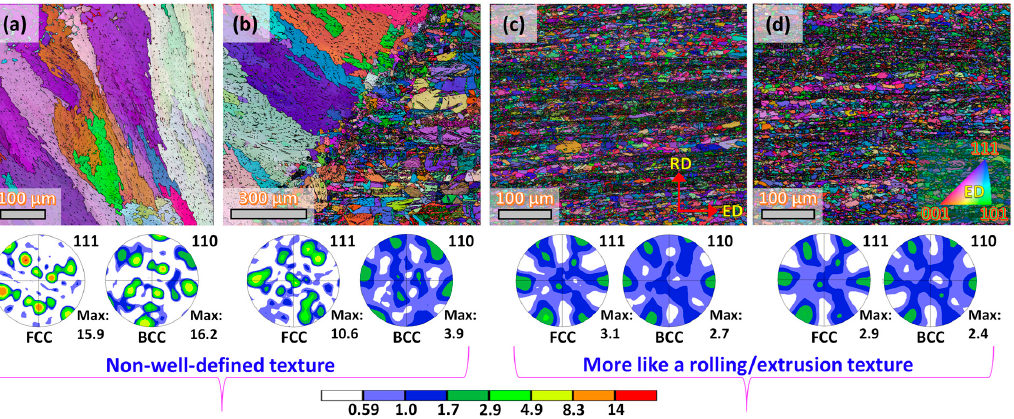
Figure 7. Inverse pole figure maps and the corresponding pole figures for the fcc and bcc crystal structures. ( a ) FZ, ( b ) fusion line between the FZ and HAZ, ( c ) BM1, ( d ) BM2.